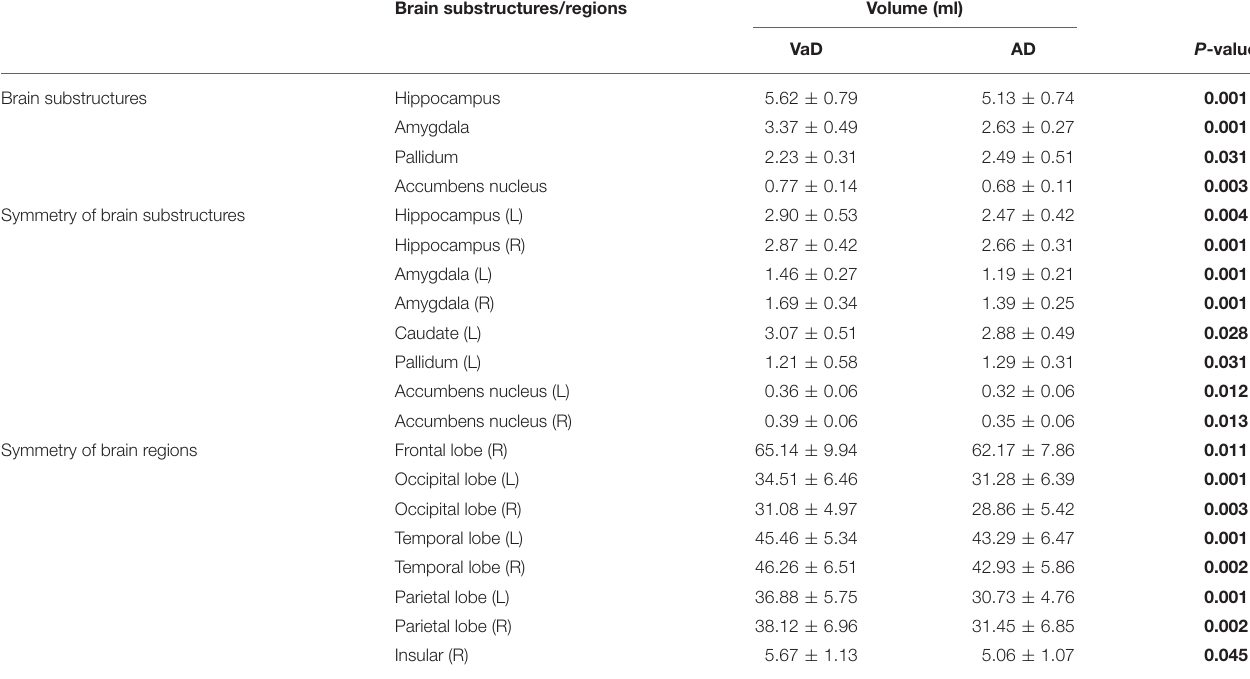
TABLE 3 | The structural MRI features with statistical differences between patients with VaD and